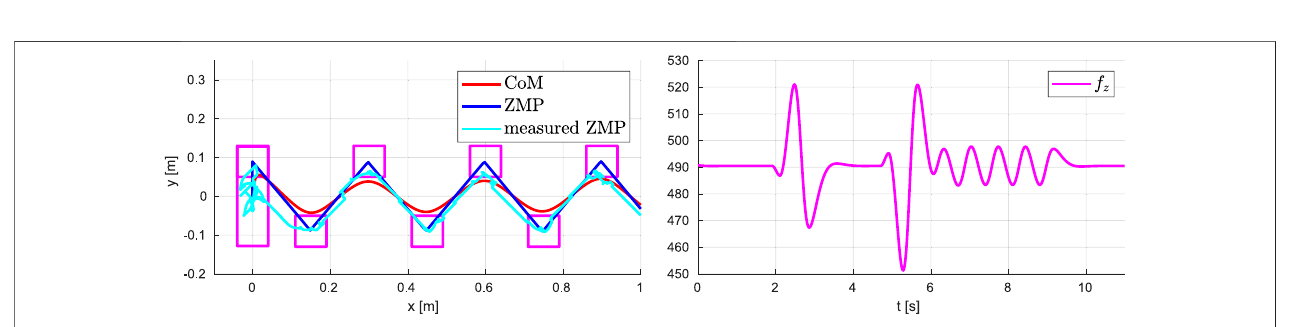
FIGURE 10 | Walking on fl at ground with variable CoM height: CoM/ZMP trajectories (left) and vertical GRF (right).